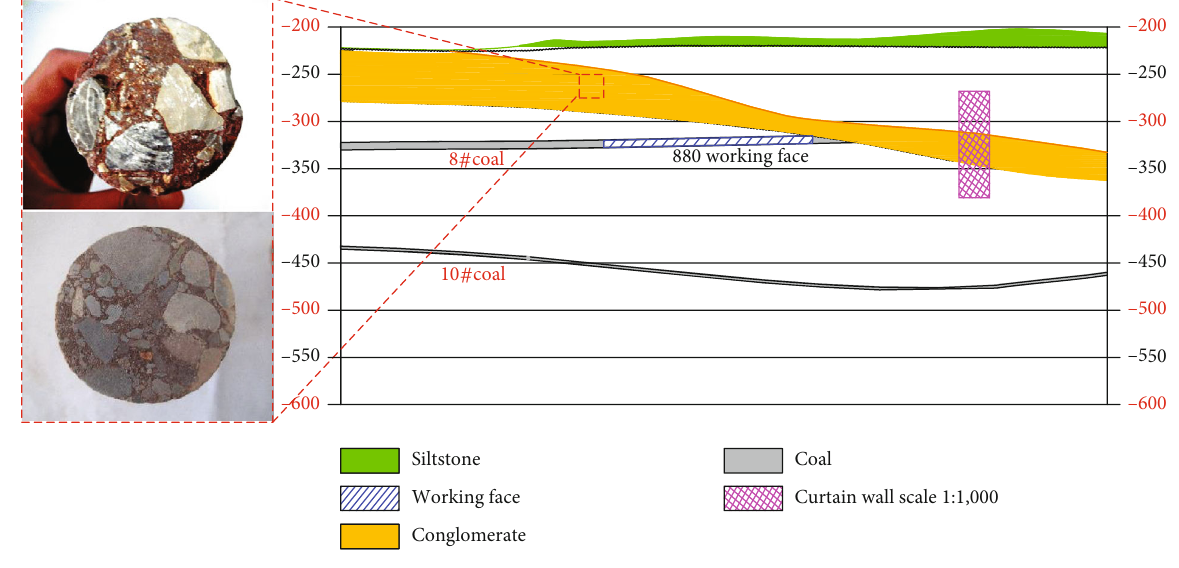
Figure 1: Occurrence of the wedge-structure immediate roof.